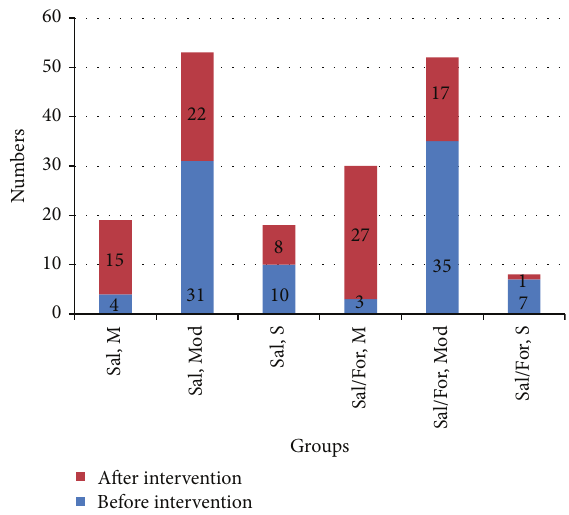
Figure 2: Bar chart of the number of patients in each group with mild,moderate,orseveredyspneaandcomparisonofthesenumbers before and after intervention. (Sal, M: salbutamol, mild, Sal, Mod: salbutamol, moderate, Sal, S: salbutamol, severe, Sal/For, M: salbuta- mol/furosemide, mild, Sal/For, Mod: salbutamol/furosemide, mod- erate, and Sal/For, S: salbutamol/furosemide, severe).